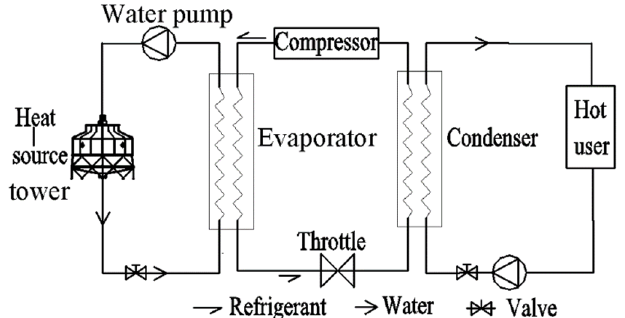
Figure 2. Experimental set-up schematic.